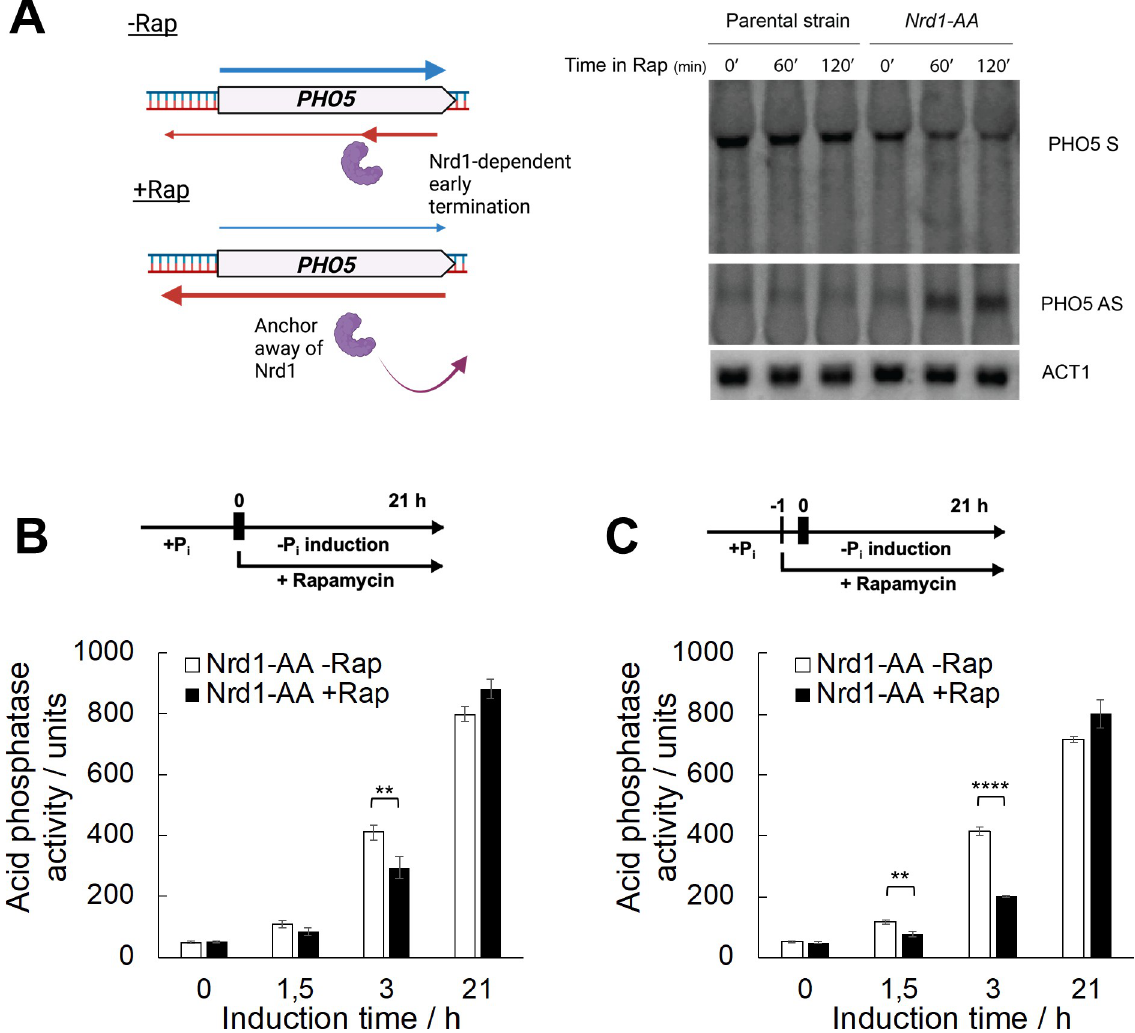
Fig 3. Induction of PHO5 AS elongation by depletion of Nrd1 from the nucleus delays expression of the PHO5 gene. (A) Nothern blot analysis of total RNA from the parental Anchor Away (AA) and the corresponding Nrd1-AA strains upon addition of rapamycin to the growth medium. Nothern blots were probed specifically for sense and antisense PHO5 transcripts, while ACT1 RNA was used as a loading control. (B) Acid phosphatase induction kinetics in Nrd1-AA strain upon induction through phosphate starvation with (+Rap) or without addition of rapamycin (-Rap). Reported values represent the means and standard deviations of three independent experiments (n = 3). Indicated differences show the significant differences using an unpaired Student’s t test. Two ( �� ) and four ( ���� ) asterisks denote a p-value lower than or equal to 0.01 and 0.0001, respectively. (C) Same as (B), but rapamycin was added one hour before